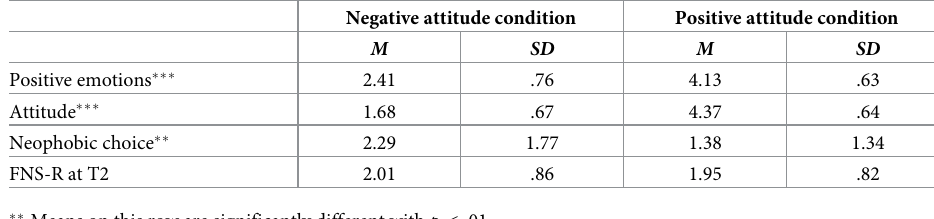
Table 7. Means and standard deviations as a function of experimental conditions (Study